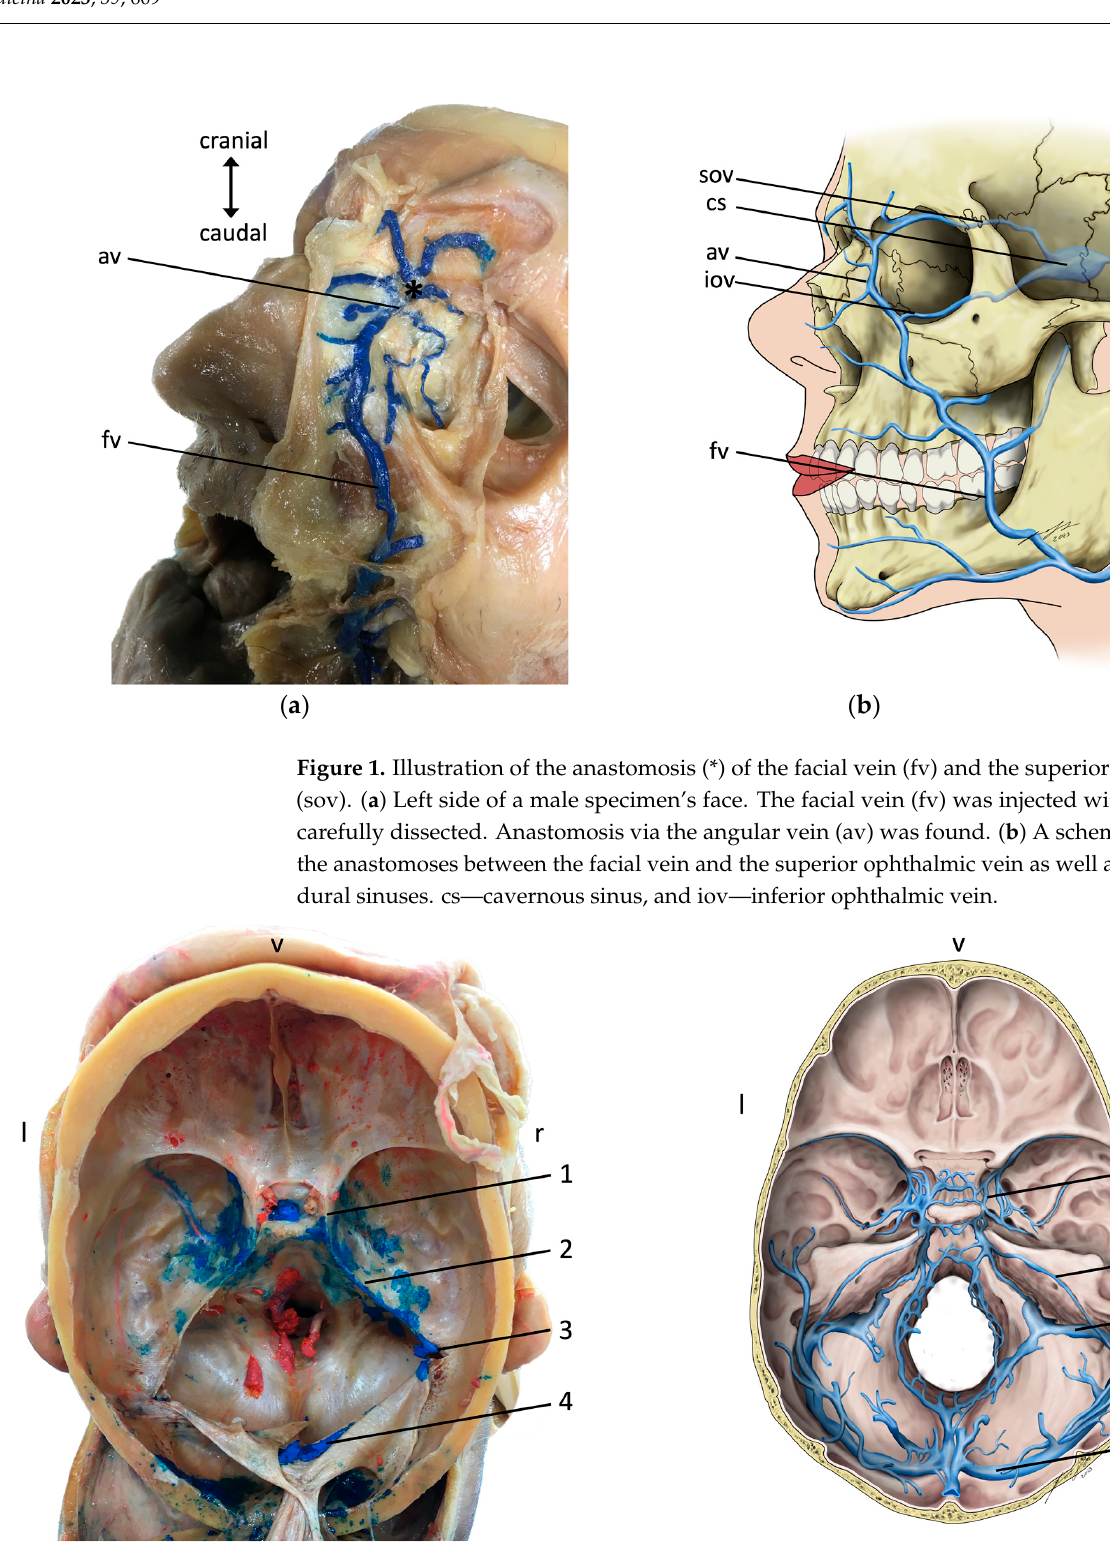
Figure 2. Illustration of the intracranial aspect of the dural sinuses. ( a ) A specimen’s intracranial aspect after removal of the calvaria and the brain. The dispersion of the latex injected via the facial vein into the (1) cavernous sinus, (2) the superior petrosal sinus, (3) the sigmoidal sinus, and (4)